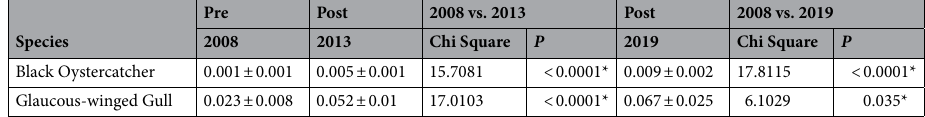
Table 2. The mean number km −1 ± SE of Black Oystercatchers and Glaucous-winged Gulls detected on beach transects “Pre” (2008; n = 16) and “Post” rat eradication (2013; n = 16 and 2019; n = 16). * P is significant with α <